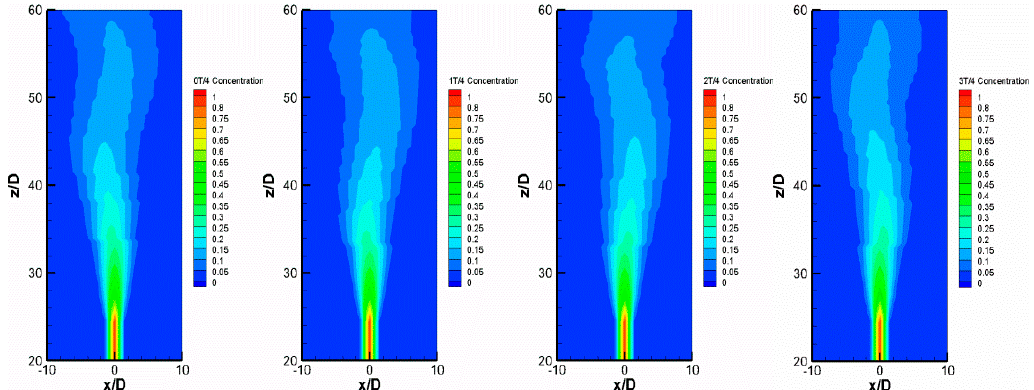
Figure 5. Concentration distributions at different phase moments of the vertical jet (VW9) in the wave environment.